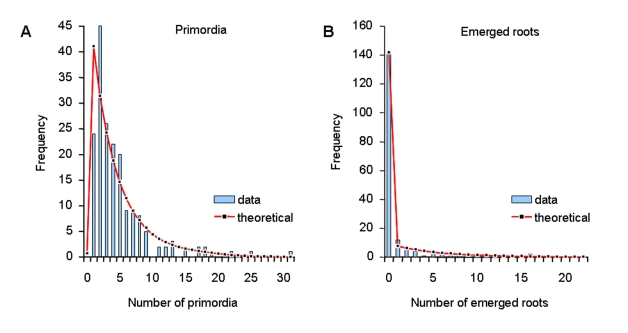
Primordia and lateral roots distributions in the stochastic model.The observed distributions (number of lateral organs of a given type per root) are extracted from the data while the theoretical distributions are computed from the estimated stochastic model.